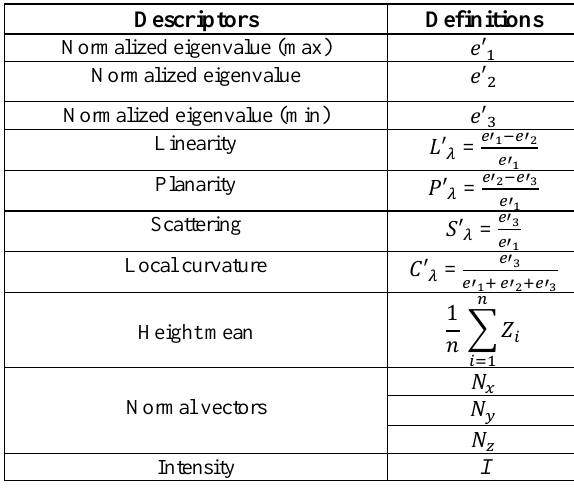
Table 1. List of the applied descriptors in the point cloud classification